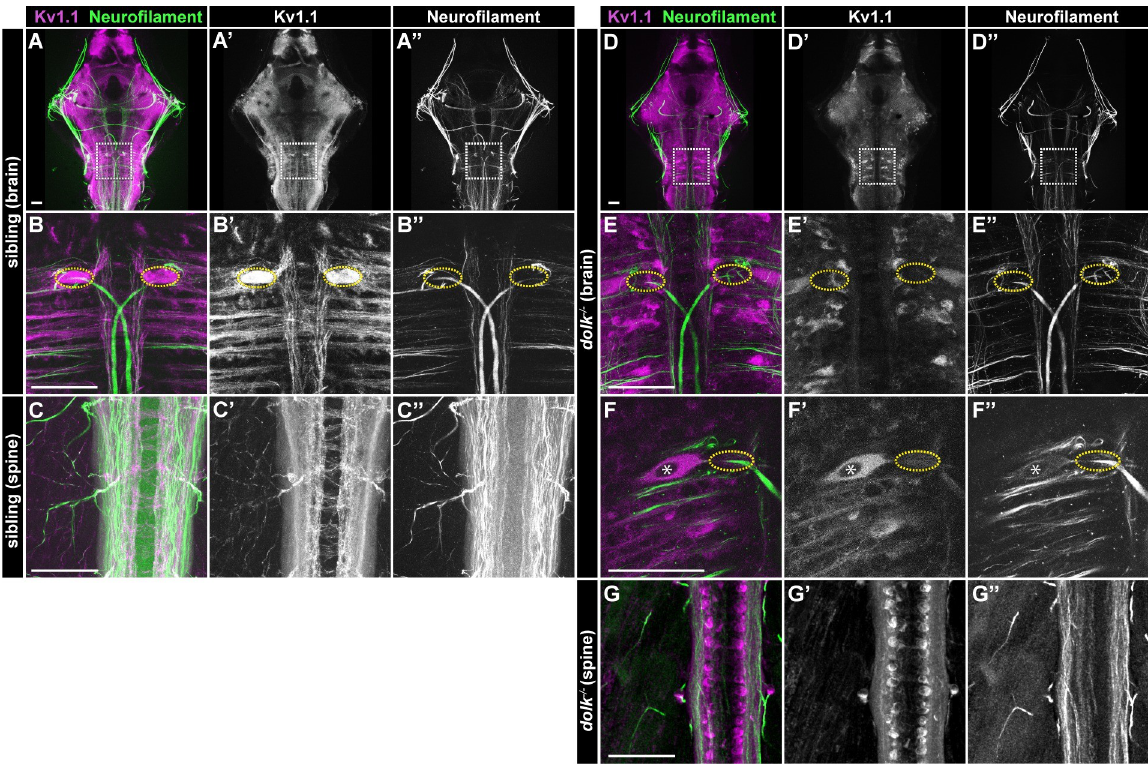
Fig 4. Dolk is required for proper localization of Kv1.1. (A-C) In 5 dpf dolk sibling larvae, Kv1.1 (magenta:A,B,C; grey:A’,B’,C’) localizes to fiber tracts ( α -3A10 antibody stains neurofilament; green:A,B,C; grey:A”,B”,C”) throughout the brain (A; box indicates hindbrain zoom in B) and spinal cord (C). Particularly high accumulation of Kv1.1 is observed at the axon cap (B, yellow dotted circle), where spiral fiber neurons form axo-axonic synapses with the Mauthner cell. (D-G) In dolk mutants, Kv1.1 is localized within somata of neurons throughout the brain and spinal cord and is strongly reduced along axons throughout the hindbrain (D,D’,E,E’). Soma localization is particularly apparent in the large Mauthner neuron, and Kv1.1 is strikingly absent from its axon cap (F, nucleus marked by asterisk, E,F axon cap marked by dotted ovals). Scale bars = 50 μ